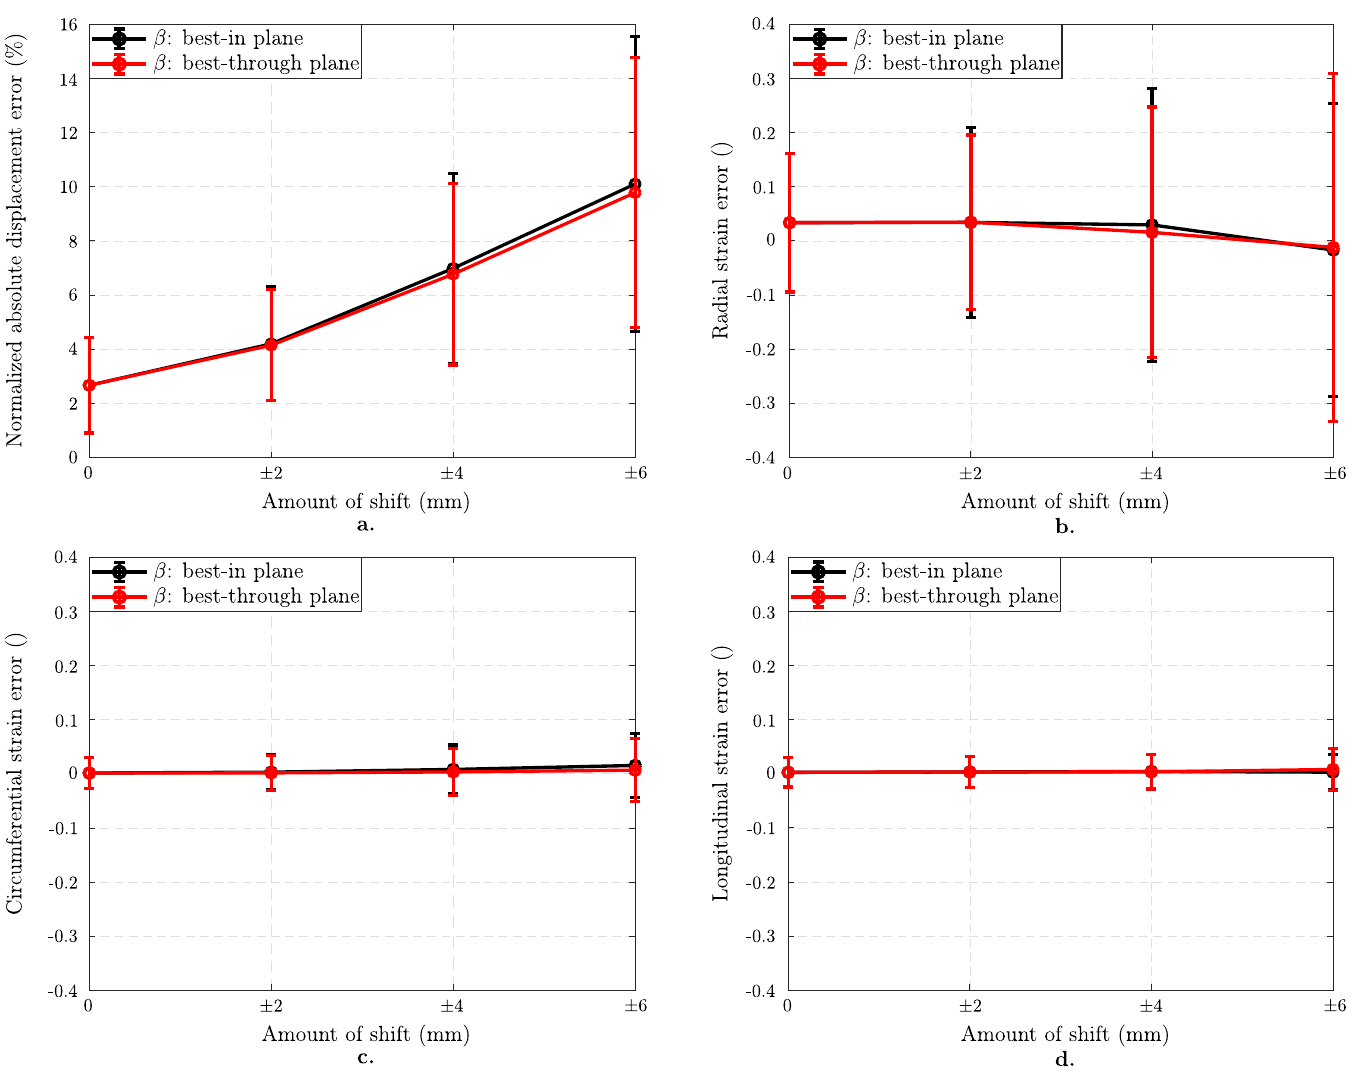
Fig 9. Effect of geometrical inconsistencies. Results on images with anisotropic pixel size 3.5x7.0x7.0 mm 3 and SNR 20 for 7 mm tag distance. Normalized mean ± standard deviations in displacement error norm (%) plotted as a function of in-plane and through plane shift (in mm) between image stacks (a). Mean ± standard deviations in component-wise Green-Lagrange strain error as a function of in-plane and through plane shift (in mm) between image stacks (b-d). Increasing amount of shift leads to an increased error in radial strain component (b) while there is almost no change in the circumferential (c) and longitudinal (d) components.